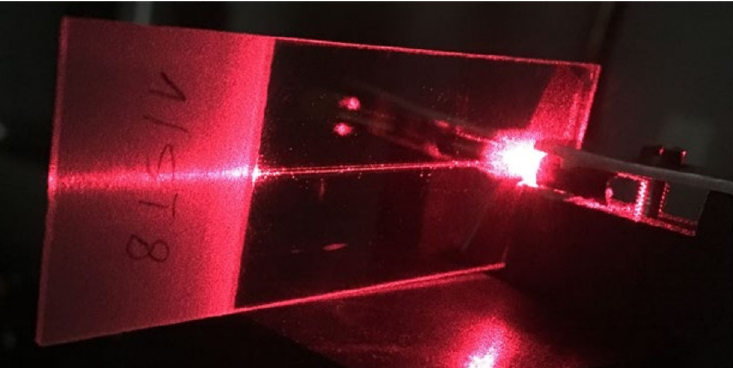
Figure 12. Image of the slab waveguide with visible streak of scattered light for excited TM 0 mode. The silica–titania waveguide film has refractive index n 1 = 1.91 and thickness d = 138